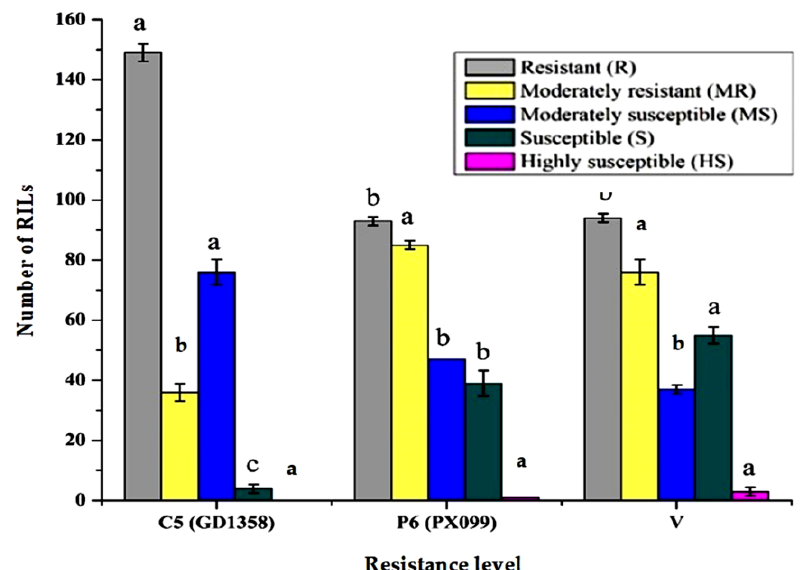
Figure 2. Response of plants in RIL to inoculation of fungus. Data are the average of 3 replications with disease scored from 5 leaves in each replication. Mean separation was performed by Tukey test ( p ≤ 0.05). The notation indicates resistant (R), moderately resistant (MR), moderately susceptible (MS), susceptible (S) and highly susceptible (HS).